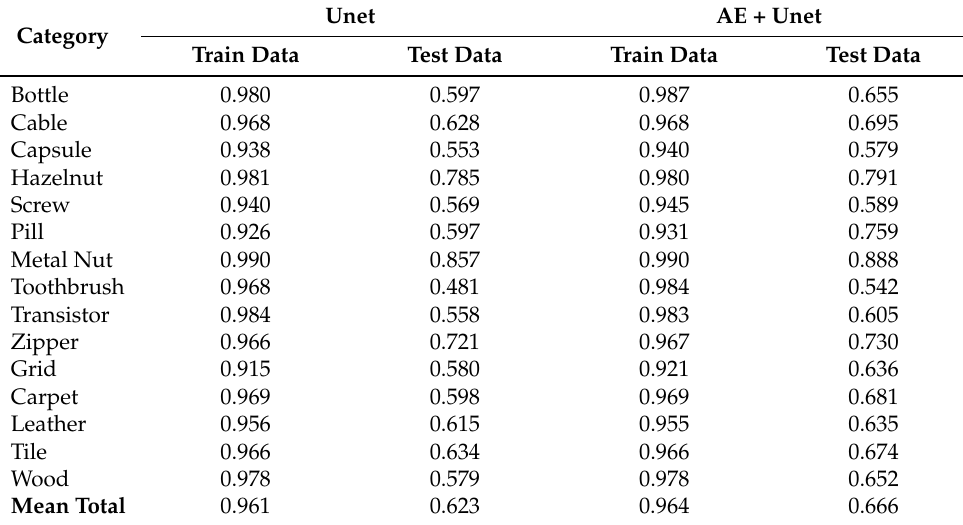
Table 3. Evaluation of the overfitting effect between Unet and our method. We report the IoUs of the results from both training and testing